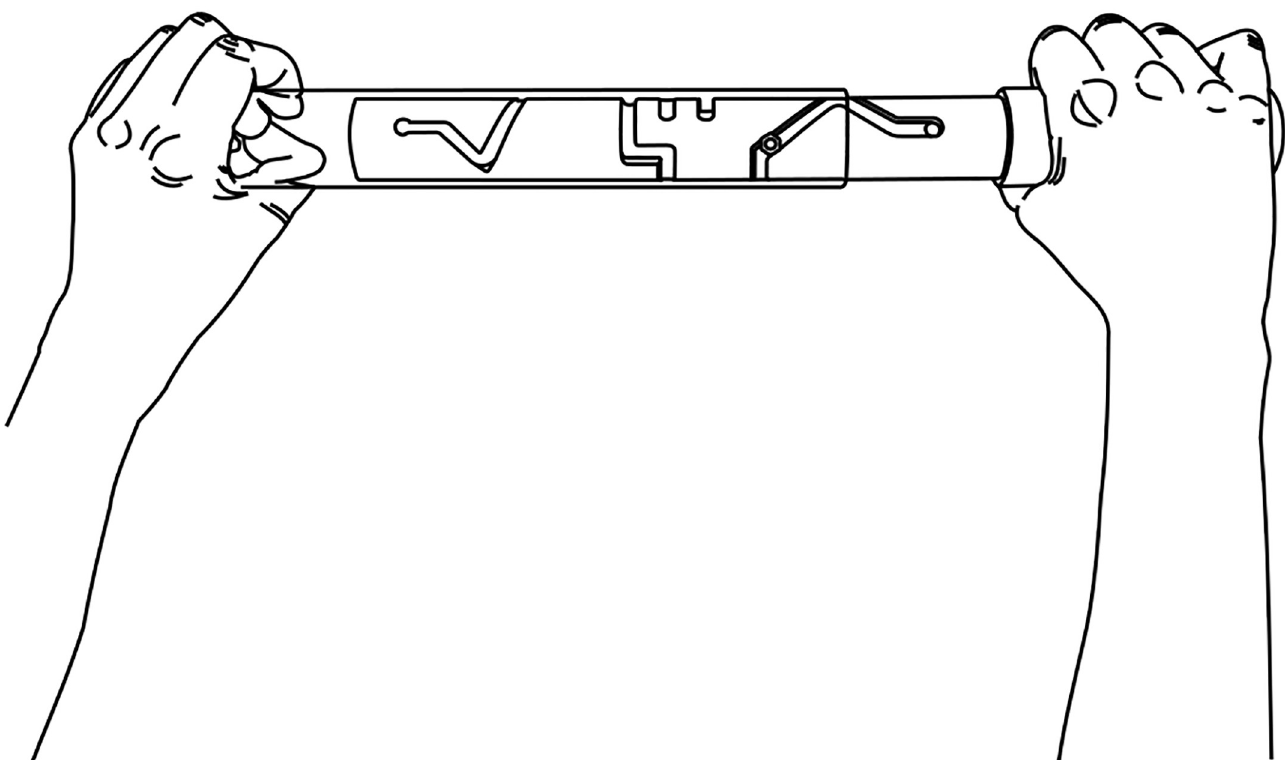
Fig 6. Bimanual coordination. Bimanual pole test. Holding the swivel stick with one hand at each end, the participant moved through the maze as fast as possible by flexing and extending their wrists in a coordinated manner. The time taken (in seconds) to move the screw from right-to-left and return was recorded as the test score.